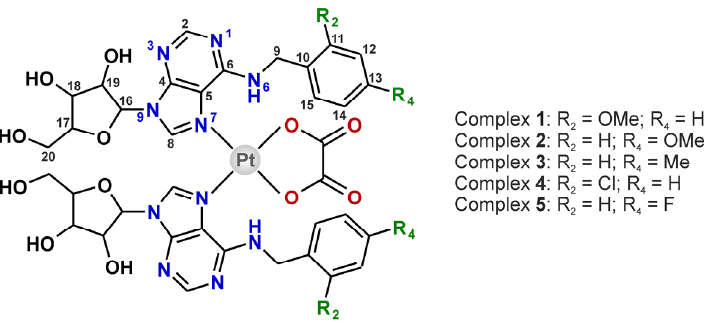
Figure 1. Structural formula of the prepared platinum(II) oxalato